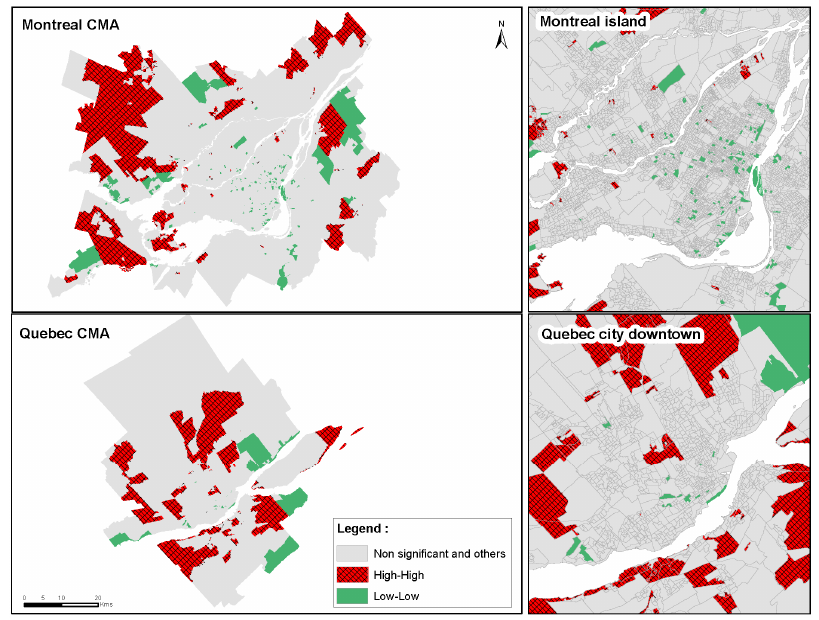
Figure 4. Bivariate local Moran maps of diabetes standardized morbidity rates and distance to green spaces equipped with sport facilities for adults ≥ 20 years living in the CMAs of Montreal and Quebec City, 2006 − 2011. CMA: Central Metropolitan Area; SMR: standardized morbidity rates; GSes: green spaces; High-High: Cluster of highest SMR and highest distance to GSes with sport facilities; Low-Low: Cluster of lowest SMR and lowest distance to GSes with sport facilities.